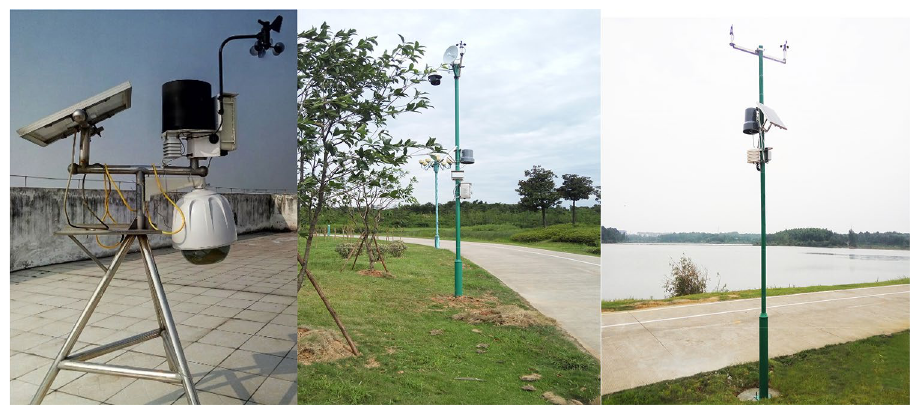
Figure 7. On-site installation equipment